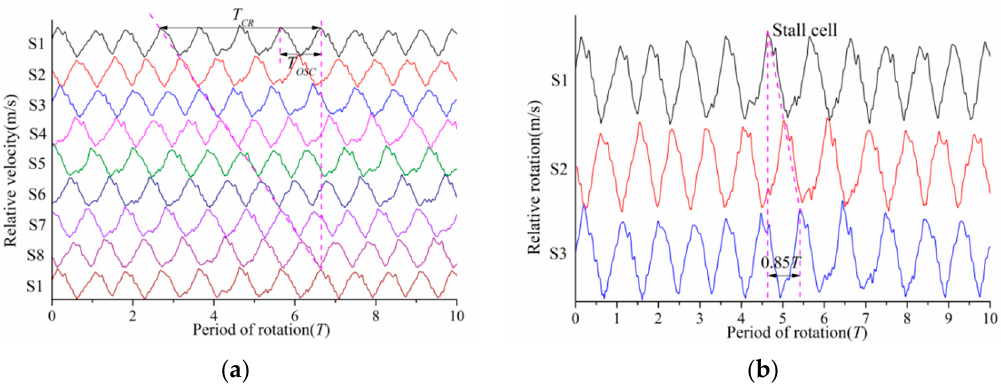
Figure 9. Relative velocity curve of the monitoring point when the flowrate is 0.9 kg/s: ( a ) the curve of the relative velocity at 8 points; ( b ) the curve of the relative velocity at 3 adjacent points.